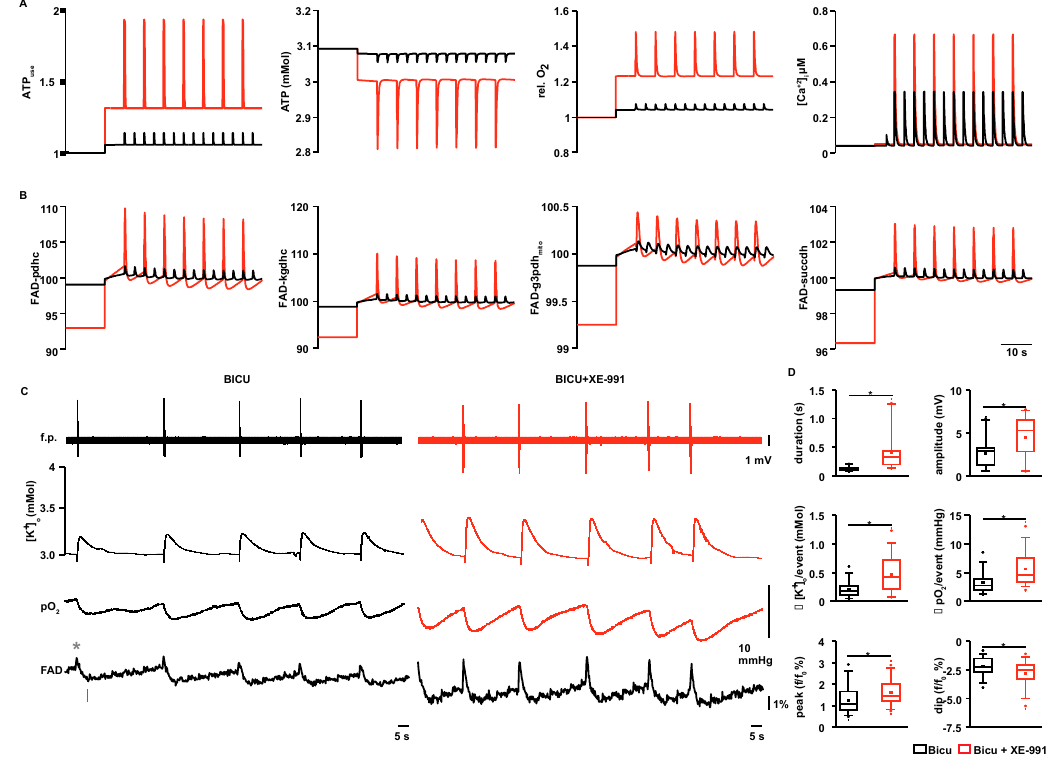
Figure 4. Modeling of basal and event-associated ATP consumption rates, ATP levels and FAD reduction states associated with ILEs and SLEs: ( A ) Basal ATP consumption increased by 6% and 32% compared with control during bicuculline ( black ) and bicuculline + XE-991 ( red ) application, which decreased cellular ATP levels to 3.08 mM and 3.0 mM. Event associated ATP consumption was higher under SLEs (~94% above control) compared with ILEs (~15% above control) and associated with a decrease in cellular ATP level to 3.05 mM and 2.81 mM. The third plot summarizes the relative changes in basal OCR and EAOCR (see also Figures 2B and 3G). Intracellular Ca 2+ transients are shown on the right; ( B ) FAD reduction states for FAD bound to pyruvate dehydrogenase complex (pdhc), α -ketogluterate dehydrogenase complex (kgdhc), mitochondrial glycerol-3-phosphate dehydrogenase (g3pdh mito ), and succinate dehydrogenase (succdh). Single events elicit increased FAD oxidation in all enzymes, with a higher peak value for SLEs compared with ILEs. In order to emphasize changes in event-associated FAD redox states, ILEs and SLEs were aligned, by manually shifting the baseline; ( C ) Simultaneous f.p., [K + ] o , pO 2 and FAD-autofluorescence recording during ILEs (black) and SLEs (red). Under submerged conditions event amplitudes were smaller, yet morphologically similar to interface conditions (Figures 1 and 2). Event duration, [K + ] o peaks and local pO 2 drops increased during SLEs compared with ILEs. Simultaneously recorded FAD-transients showed increased oxidation, which was predicted by the model. Importantly, the data used for modeling was based on recordings under interface conditions; and ( D ) Quantification for C. Similar to interface conditions, SLEs showed significantly increased event durations, [K + ] o -rises and local oxygen drops ( top and middle ). In contrast with interface conditions, f.p. event amplitudes increased from ILEs to SLEs ( top ). As predicted by the computational model, event-related FAD-transients, i.e., FAD peaks (see asterisk in C ) and dips (see arrow in C ), were significantly enhanced (bottom). * p < 0.05, n = 90 individual ILEs and 114 SLEs, independent t -test.